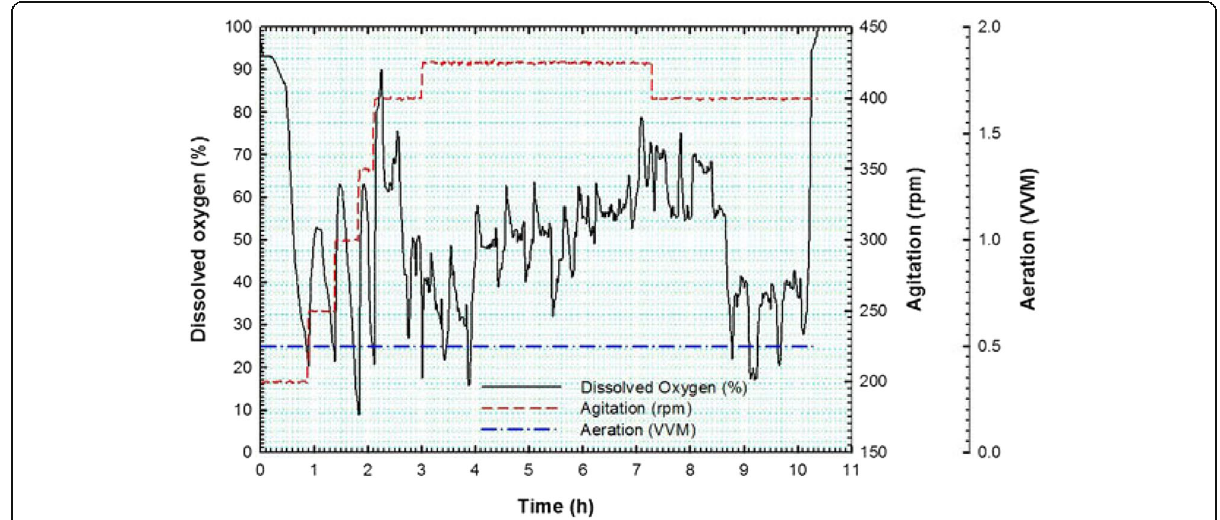
10 h (Fig. 8). Percentage of juvenile mortality of M. in- cognita [at a concentration of 5% (1:20)] at 2 h recorded 13.3% and reached its highest value of 74.3% at 10.5 h. Glucose concentration decreased rapidly reaching 0 g/l at 7 h. Cell mass increased exponentially over time with a constant specific growth rate of 0.09 h − 1 within the ex- ponential phase, resulted from the logarithmic relation- ship (Fig. 9). In this figure, the values of the ln X (values of X were obtained by using the correlation coefficient δ , 0.5 calculated from the linear relationship among dry mass weight and optical density shown in Fig. 10) were presented by a straight line on a semi-logarithm plot against time. The behavior in this phase allowed estimat- ing the yield coefficient Y (0.66 g cells/g glucose) as X/S showed in Fig. 11. Culture was maintained at a higher value of dissolved oxygen, which decreased gradually